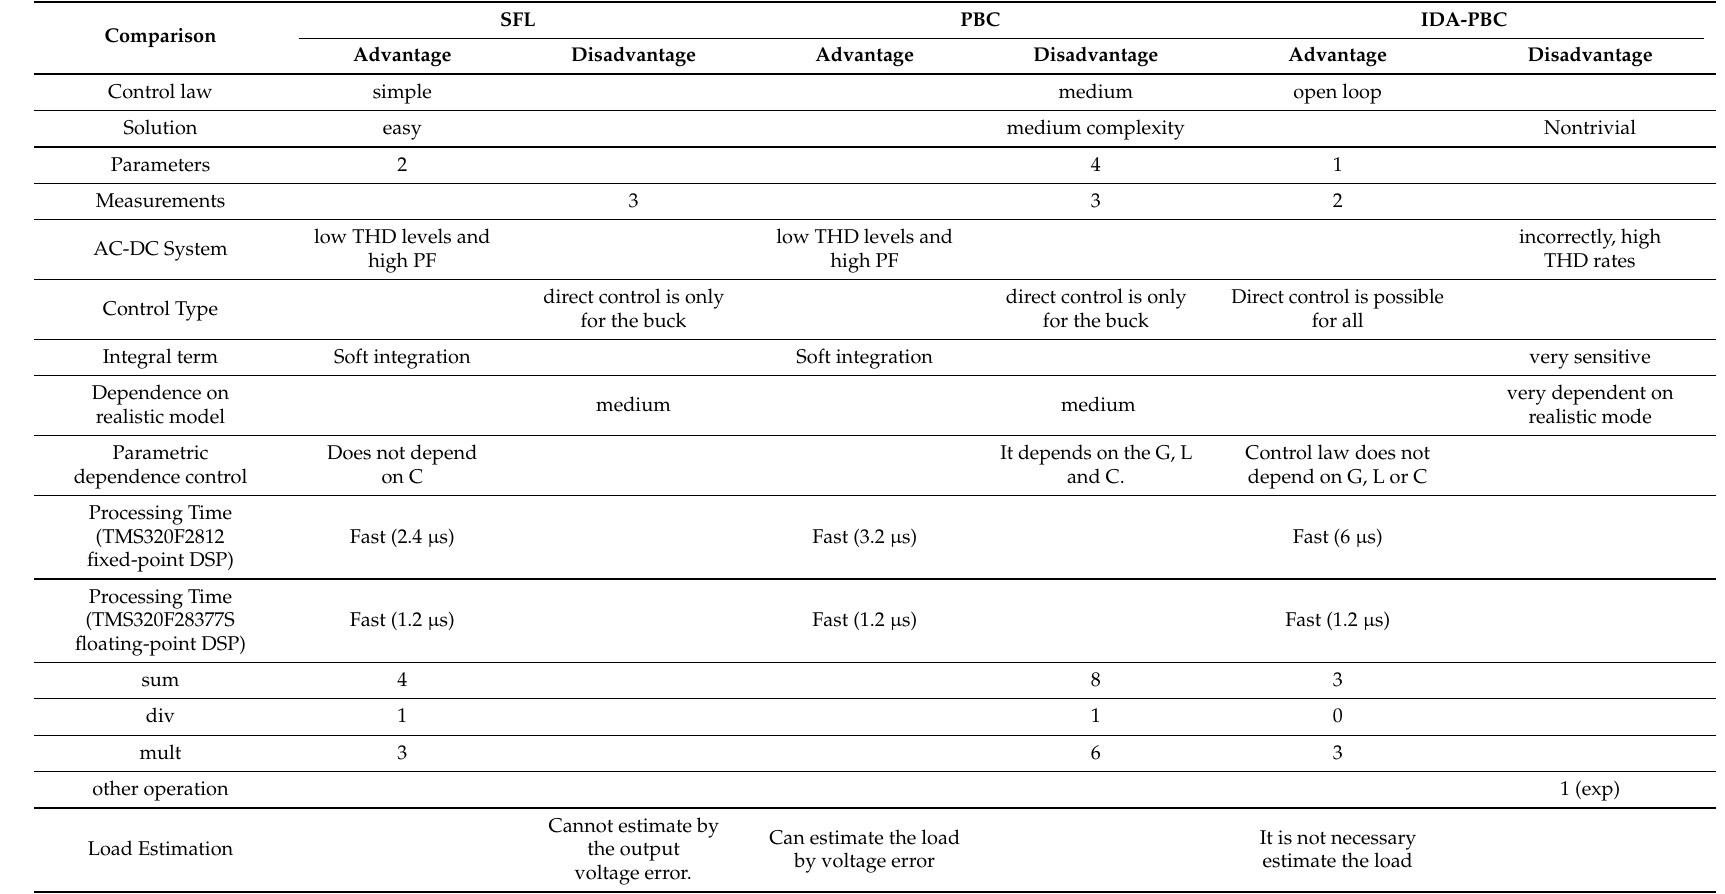
Table 6. Comparison of non linear control